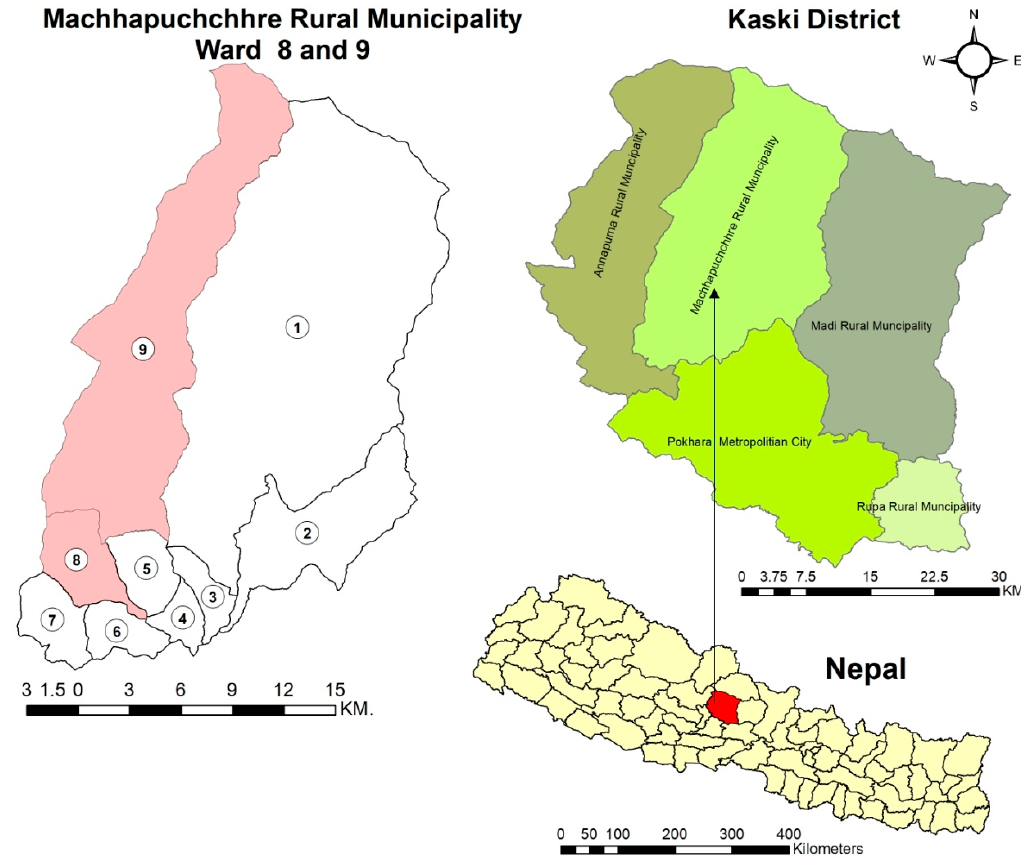
Figure 1. Map of the study area (Machhapuchchhre Rural Municipality) in the Kaski district of Nepal.